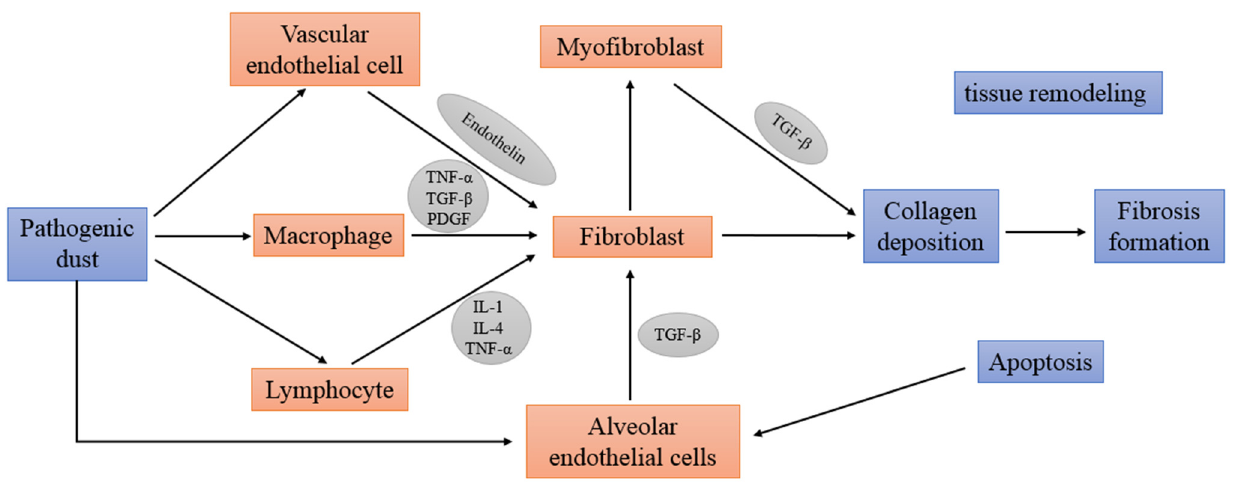
Figure 1. Hypothesis of pathogenesis of coal workers’ pneumoconiosis [10].